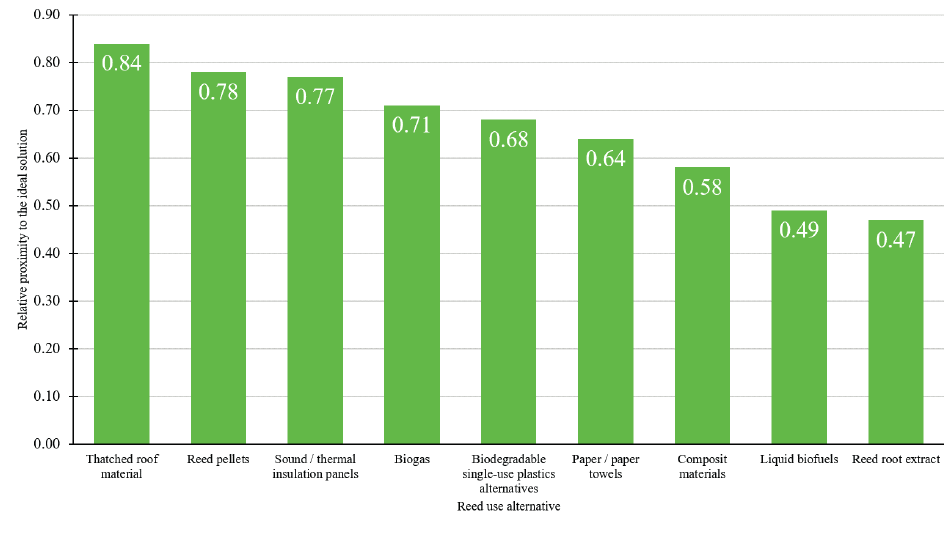
Fig. 5. TOPSIS MSDM analysis